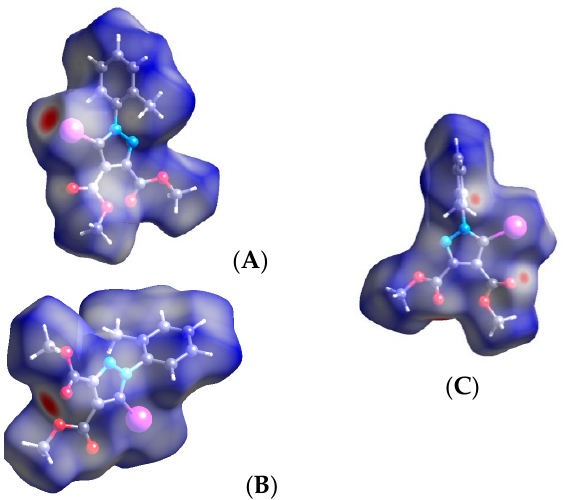
Figure 12. Hirshfeld surface of compound 1 showing the red spots corresponding to the C-I ⋯ O interactions ( A , B ) and for hydrogen close contacts ( C ). Halogen bond parameters: C-I bond length: 2.075 Å; I ⋯ O distance: 2.993 Å; sum of the vdW radii: 3.5 Å [58]; ∠ C-I ⋯ O: 175.2°.